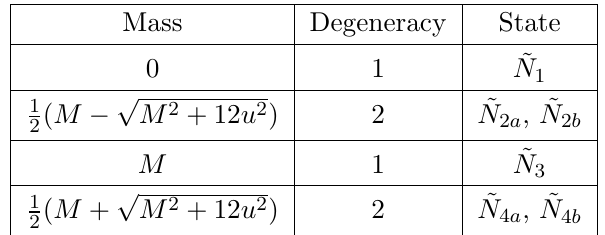
Table 2. Mass eigenstates of the neutralino mass matrix M ~ in (5.48) and (5.54)